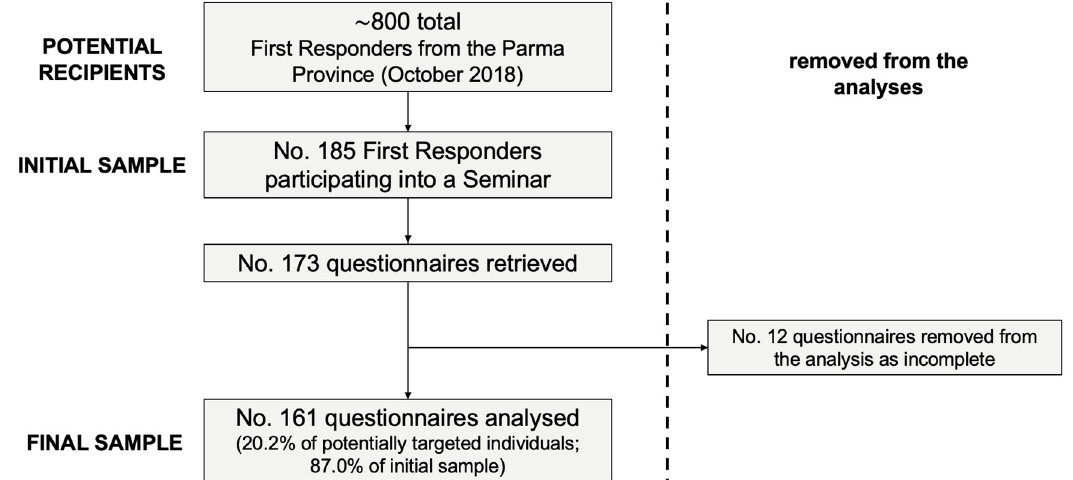
Figure 1. Flow chart of sampled participants.